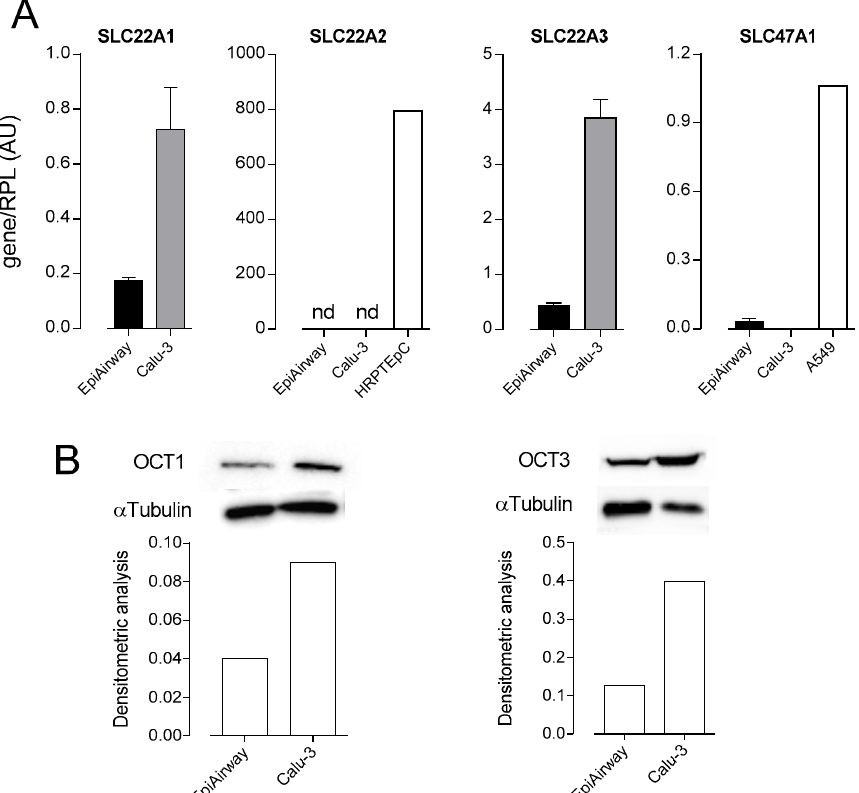
Figure 2. Expression of Organic Cation Transporters (OCTs) and Multidrug and Toxin Extruder 1 (MATE1) in EpiAirway ™ and Calu-3. ( A ) mRNA levels for SLC22A1 / OCT1, SLC22A2 / OCT2, SLC22A3 / OCT3, and SLC47A1 / MATE1 were determined by means of qRT-PCR and normalized for the expression of the reference gene ( RPL15 ) (see the Section 2). cDNA obtained from human renal proximal tubular epithelial cells (HRPTEpC) and A549 alveolar cells was employed as positive control for the analysis of SLC22A2 / OCT2 and SLC47A1 / MATE1 expression, respectively. Data are means ± SEM of five determinations. ( B ) The expression of OCT1 and OCT3 proteins was determined by Western Blot analysis, as described in the Material and Methods Section. Lower panels present the results of the densitometric analysis of protein expression, normalized to that of α -tubulin. A representative Western blot is shown, and the experiment was repeated two times, with similar results.